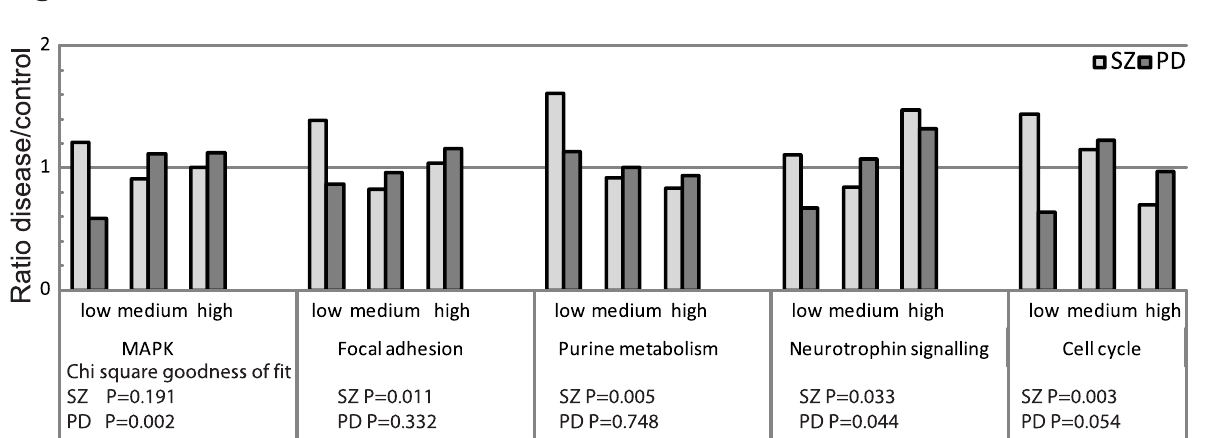
Figure 4. Expression variance discriminates between disease groups. A. Box plots showing whole-genome phenotype-specific mean expression levels and the corresponding CVs for hONS cells derived from the Control, PD, and SZ patient groups. As can be seen, there is no difference in the average log 2 (expression) measures but noticeable differences in the CVs. Using a two-sample t-test, there is a significant difference between the SZ and Control groups (p-value , 2.2 6 10 2 16 ) and the PD and Control groups (p-value , 0.0013). B. The observation of increase in high- variance genes for PD and increase in low-variance genes for SZ persists with different percentile cutoffs applied to the variance distribution in the